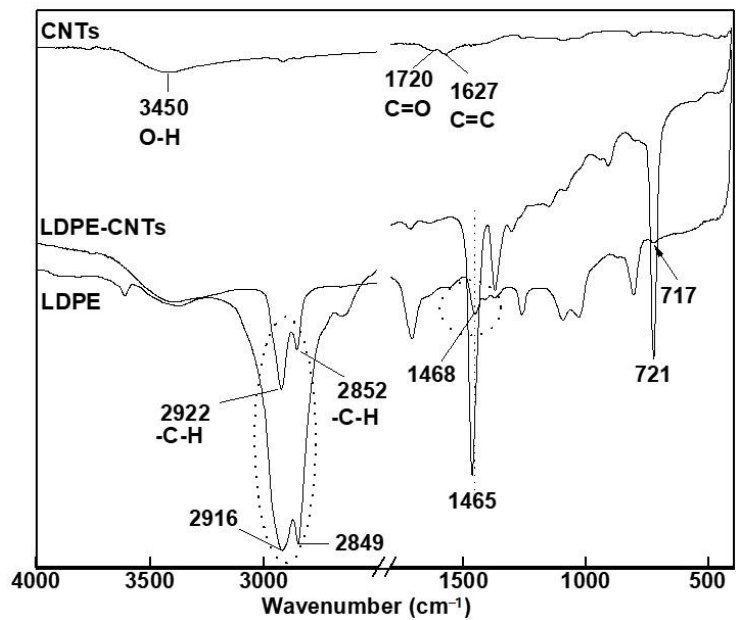
Figure 5. FTIR spectrum of pure CNTs, pure LDPE, and Figure 5 . FTIR spectrum of pure CNTs, pure LDPE, and LDPE-CNTs. In the spectra of pure LDPE, the two split peaks at 2916 and 2849 cm −1 are assigned to the asymmetric and symmetric stretching vibration bands of -CH 2 -; the peaks at 1465 and 721 cm −1 correspond to the deformation vibration band and in-plane rocking vibration band of -CH 2 -, respectively [39]. In contrast, the direct crystallization of LDPE on the long axis of CNTs (LDPE-CNTs) indicates a small shift of the asymmetric and symmetric stretching vibration band (-CH 2 -) from 2916 and 2849 cm −1 in PE to 2922 and 2852 cm −1 , respectively, in the CNT-LDPE nanohybrid structure. This shift is ascribed to the favora- ble physical interaction between PE and CNTs [40]. Furthermore, it also suggests non- covalent and nonspecific -CH- π interactions between PE and CNTs lead to crystallization along the axis of the CNTs. It has been suggested that the physical interaction of the -C-H group of a polymer with CNTs is expected to result in broadening, shift and/or split in the frequency of the - C-H stretching and bending vibrations of the polymer [41]. As a consequence of non-co- valent or non-specific -CH- π interactions, the polymer may wrap around the CNTs. The FTIR spectra of GO (Figure 6) is characterized by the presence of the oxygen- containing functional groups. The peaks at 1051, 1380, and 1630 cm −1 correspond to the - C-O-C- stretching vibration, -C-OH stretching, and -C=O stretching modes of the quinone skeleton of graphene, respectively, while peaks at 1730 and 3455 cm −1 correspond to -C=O stretching vibrations of the -COOH groups and -O-H stretching vibrations, respectively.